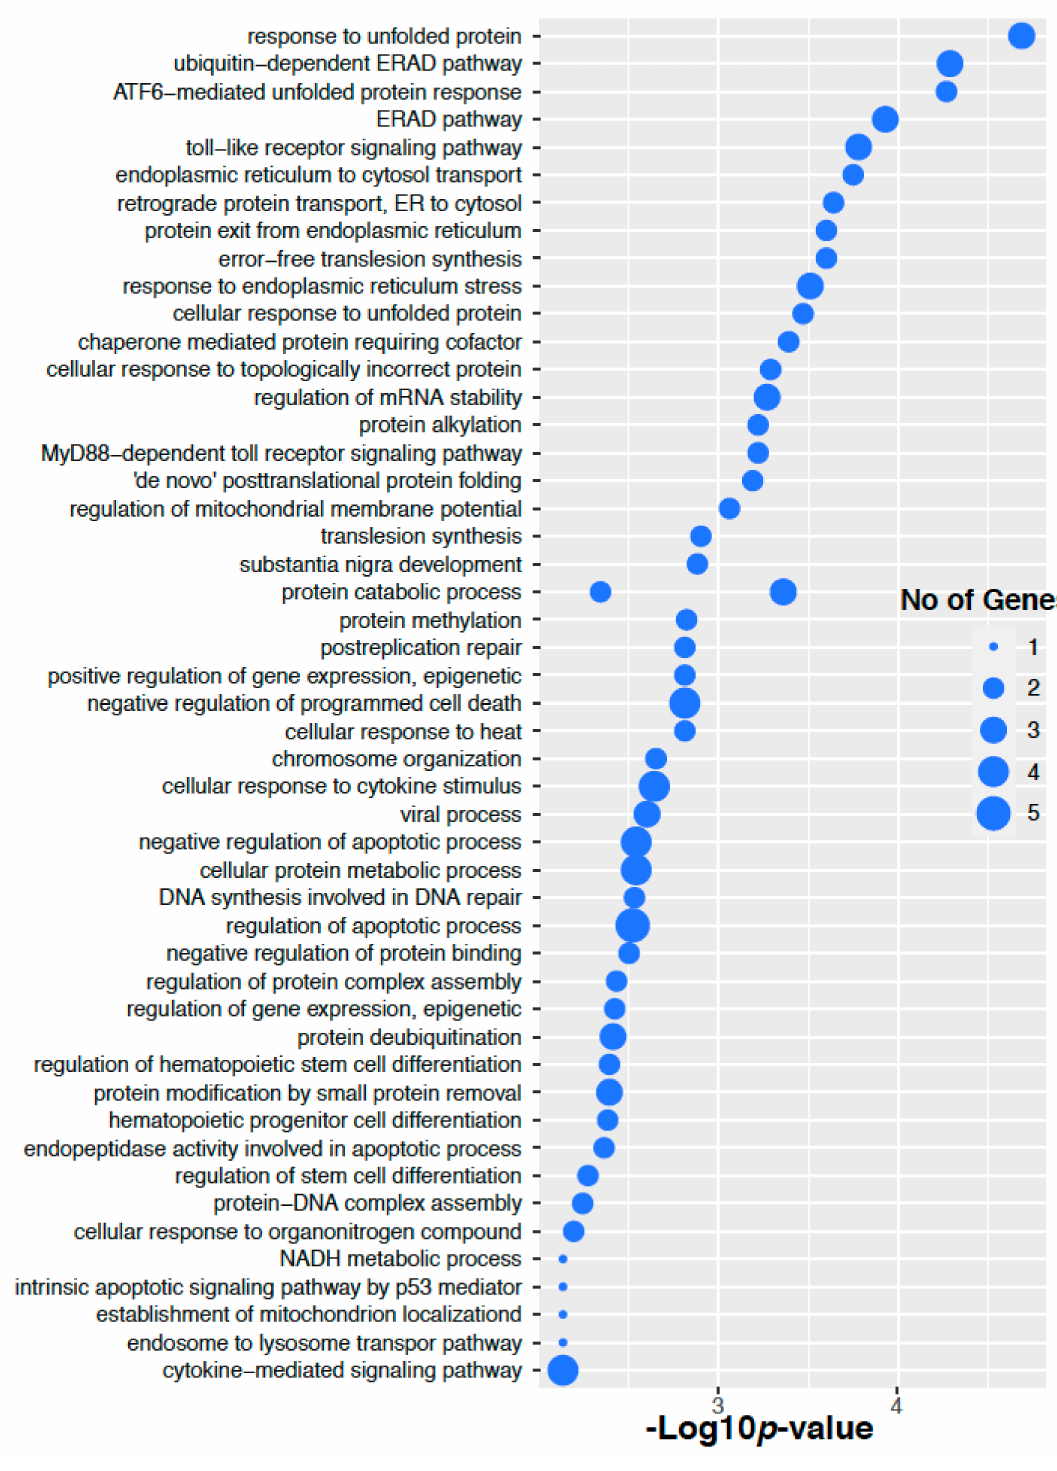
Figure 7. Gene Ontology enrichment of the genes corresponding to the altered 14 proteins in the Ovarian